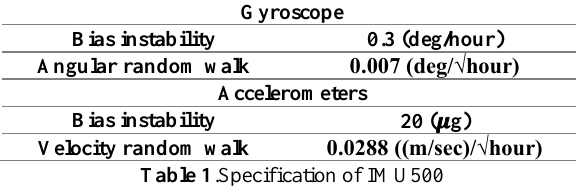
Table 3 .Parameters of error model from the user manual